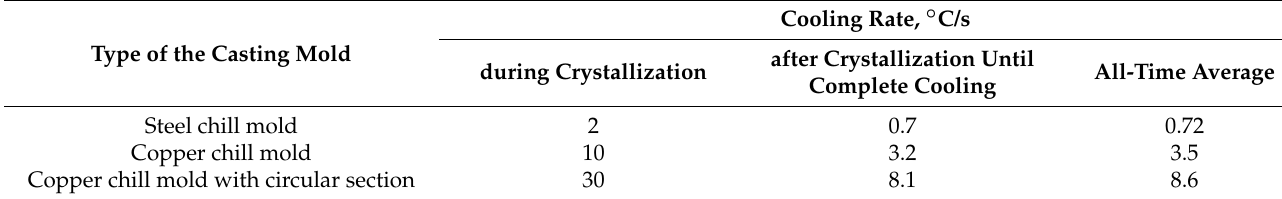
Table 2. Metal average cooling rates.